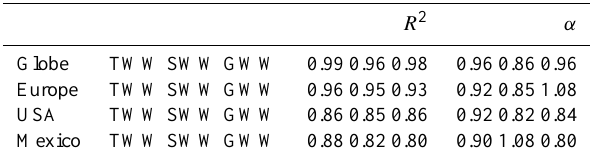
Table 4. Correlation between simulated and reported water with- drawals per source (TWW: total water withdrawal, SWW: sur- face water withdrawal, GWW: groundwater withdrawal) for the year 2005 over the globe per country ( N = 100), Europe per coun- try ( N = 34), the USA per state ( N = 50), and Mexico per state ( N = 32) in log-log plots. R 2 and α denote the coefficient of de- termination and the slope of regression line respectively. R 2 was derived from the comparisons between normal values. R